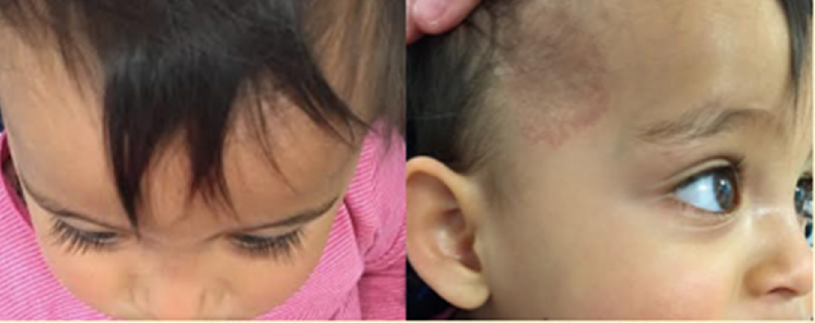
Figure 2. Axial T1 weighted and T2 weighted TSE brain magnetic resonance imaging of patient on presentation. Extensive right orbital lesion with marked proptosis. Extension of the lesion intracra- nially, with involvement of right Meckel’s cave (pointer) and the cerebellar pontine angle.